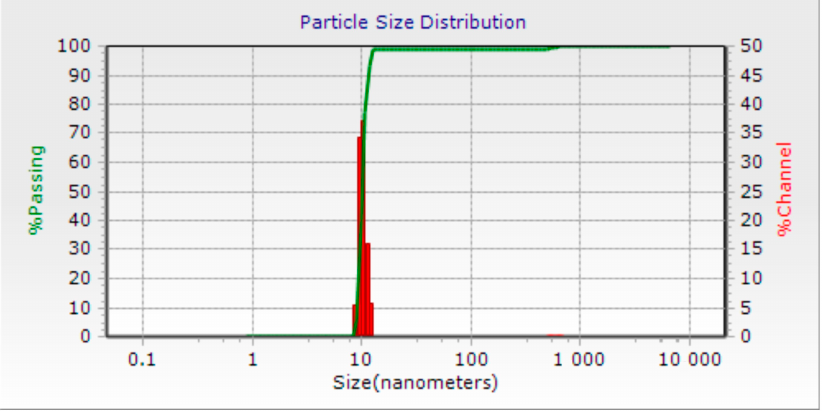
Figure 2. Particle size distribution of the AuNPs. The distribution is narrow and was measured using dynamic light scattering (DLS). The mean particle size of the AuNPs is 10 nm. It is important to note that the coating has the potential to extend the lifetime of the AuNPs in physiological media. The coating provides a longer lifetime and acts as an an- chor for the drug on the nanostructure, serving as a vehicle for drug localization. AuNPs smaller than 10 nm are rapidly excreted and metabolized by the liver due to their size, which allows for unrestricted distribution and mobilization through capillaries in the body. By coating the AuNPs with polymers such as PEG or silica, the dimensions of the AuNPs can be increased to above 10 nm, reaching up to 30 nm, which makes this size range optimal as they are not rapidly eliminated by the liver and kidneys. This can be seen in Figures 3 and 4.